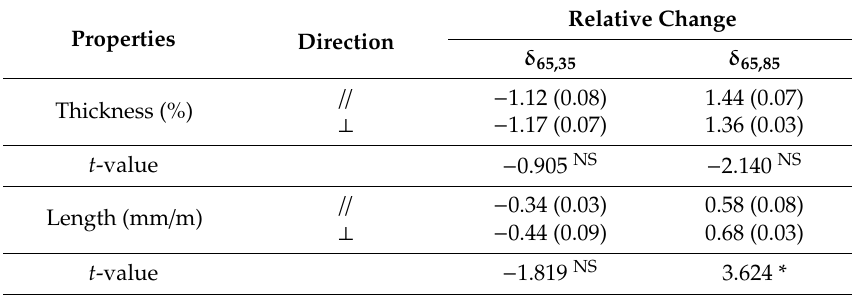
Table 3. Relative changes in thickness and length of Medite Tricoya ® MDF sample at di ff erent relative humidity (RH) levels. Values in parenthesis are the standard deviations. Relative Change Properties Direction